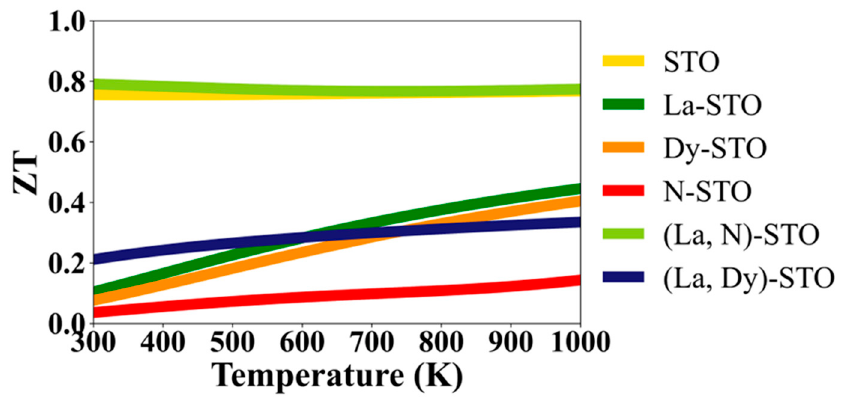
Figure 8. Dimensionless figure of merit of STO and doped STO.